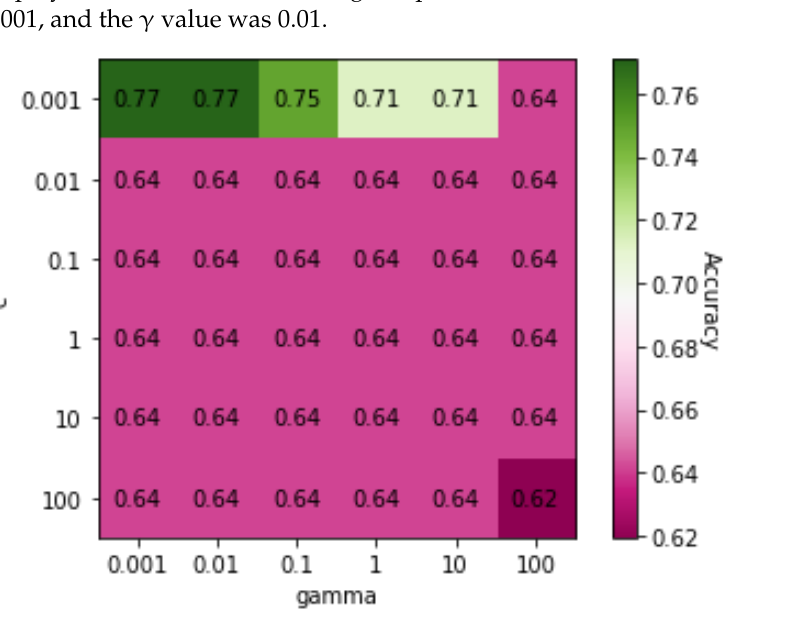
Figure 4. Heatmap of values of SVM parameters C and γ on Dataset 04.